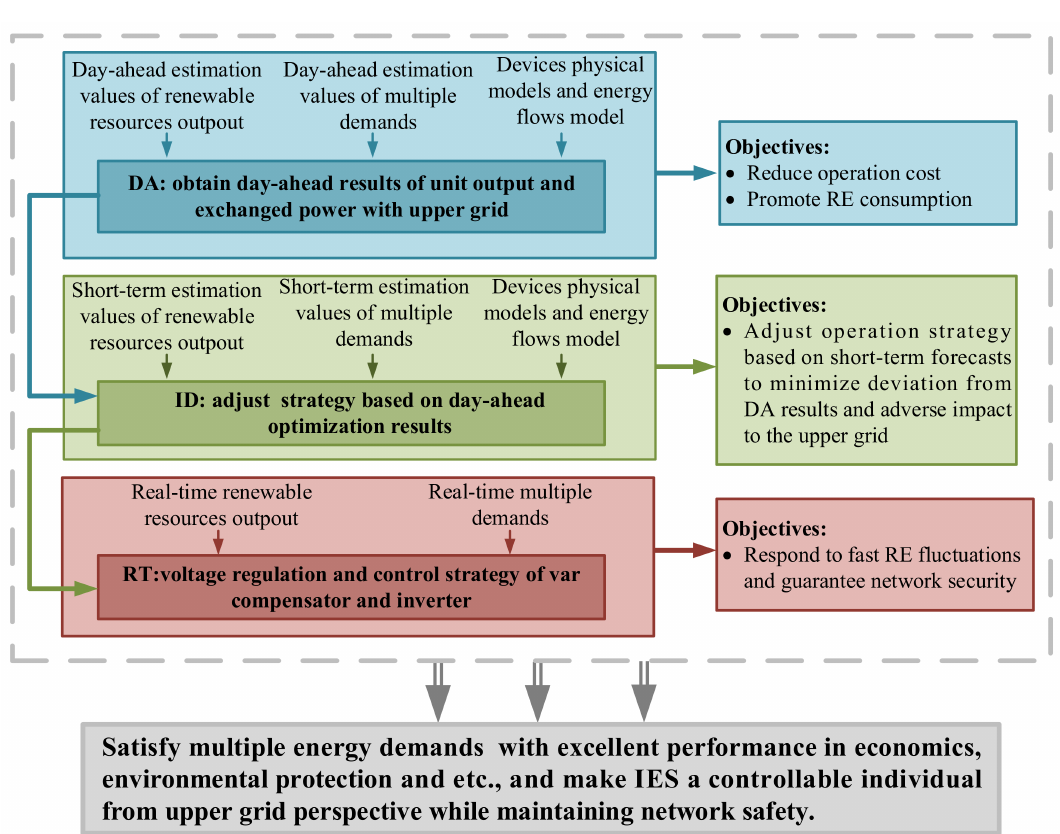
Figure 6. Flowchart of multi-stage IES optimization